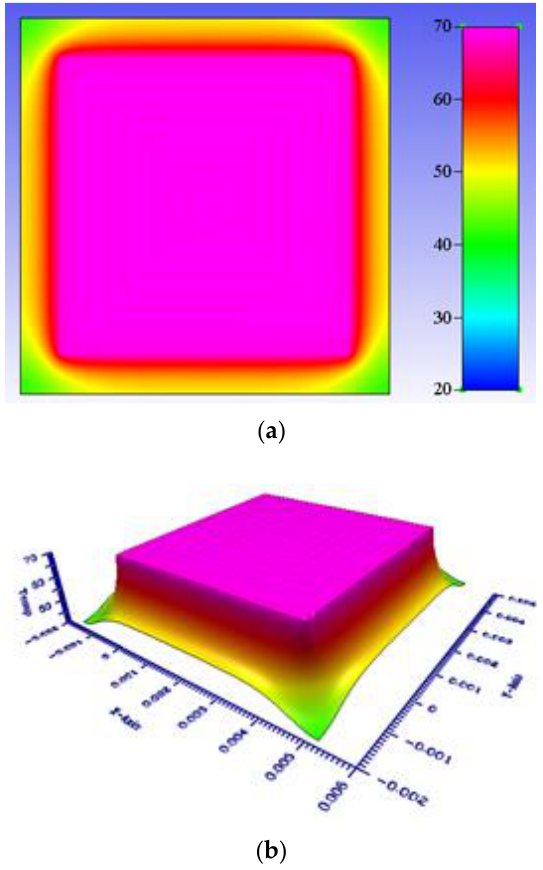
Figure 7. ( a ) 2D and ( b ) 3D numerical contours of the temperature field at an applied electric current of 1.0 A.